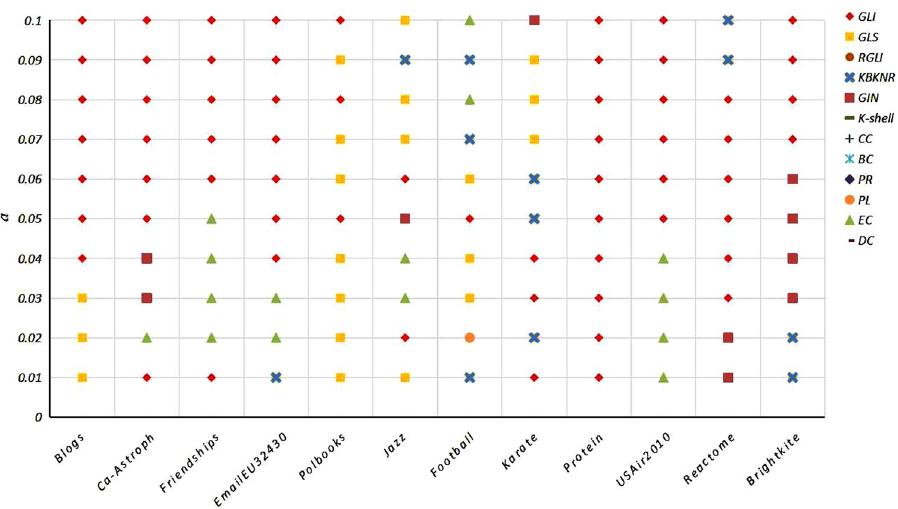
Figure 3. The maximum Kendall τ value results of the algorithms for different infection probabilities; the abscissa represents the network datasets, the ordinate indicates the infection probability α. Data presented in Fig. 3 correspond to the algorithm of the maximum Kendall τ values.